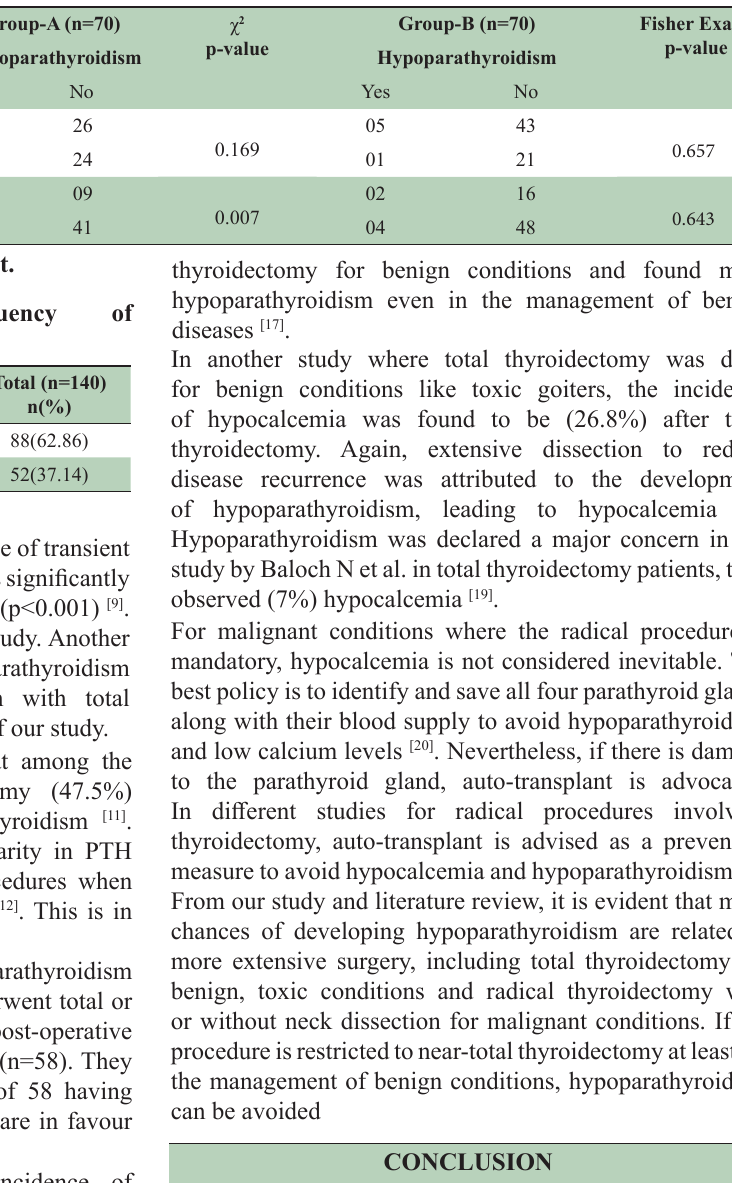
SR, Iqbal MS, Fatima T, et al Table-III: Stratification of Hypoparathyroidism with respect to age and gender in study groups.